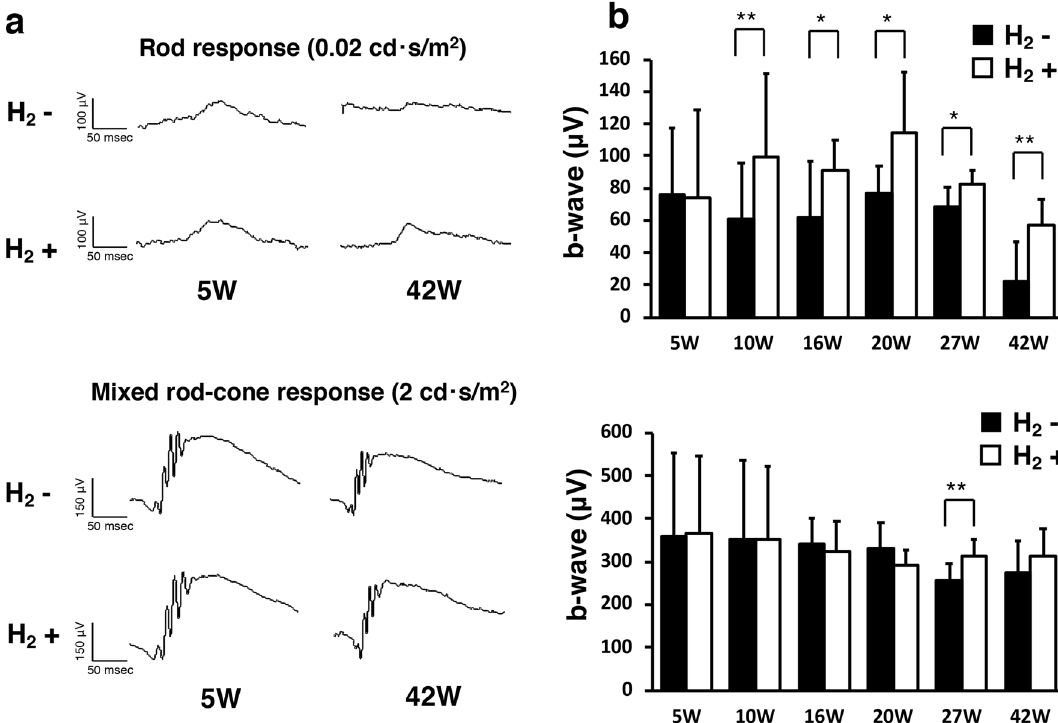
Figure 3. B-wave of ERGs in rd6 mice with/without H 2 water. ( a ) Representative b-wave with/without H 2 water at 0.02 cd·s/m 2 and 2 cd·s/m 2 . ( b ) Quantification of the b-wave amplitude from 5 to 42 weeks of age. We found a significant difference between the control group (n = 8) and H 2 group (n = 10). Bars depict means ± standard deviation (SD). *p < 0.05, **p <